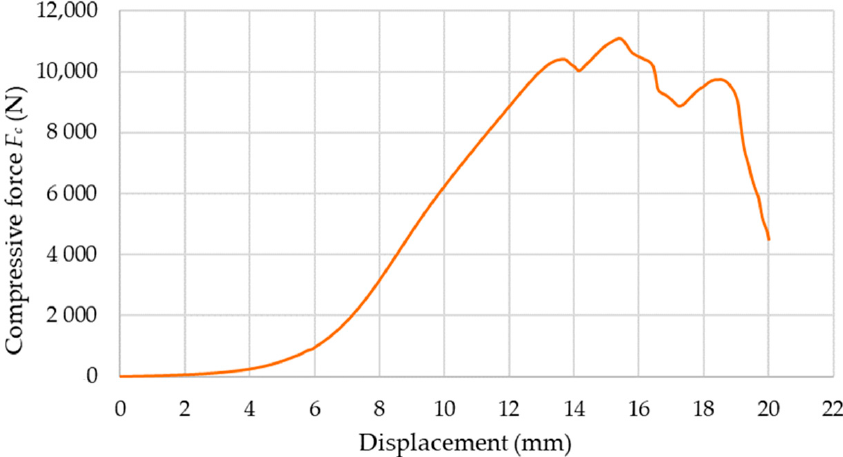
Figure 6. Characteristic curve of the compressive force F c variance applied to oak sawdust obtained during compression with a force F = 20,000 N.